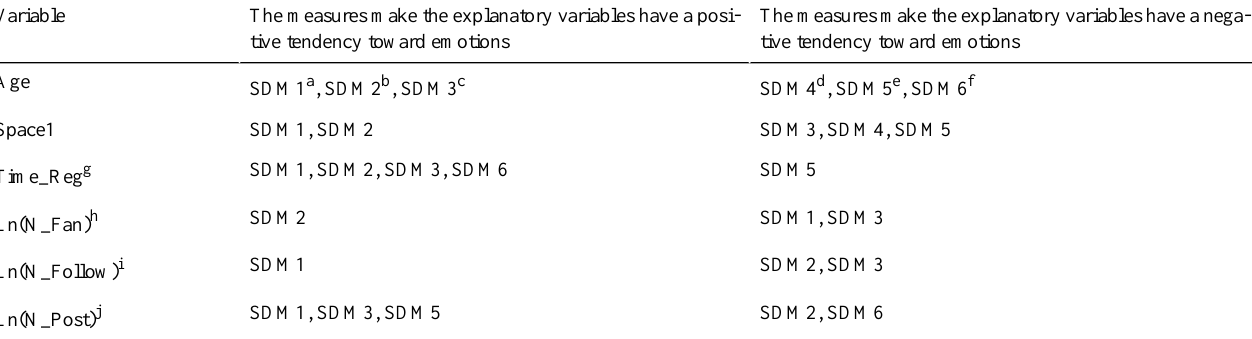
Table 6. Statistics on the emotional tendency of explanatory variables under the moderating effect of various social measures. emotionsThe measures make the explanatory variables have a posi- tive tendency toward